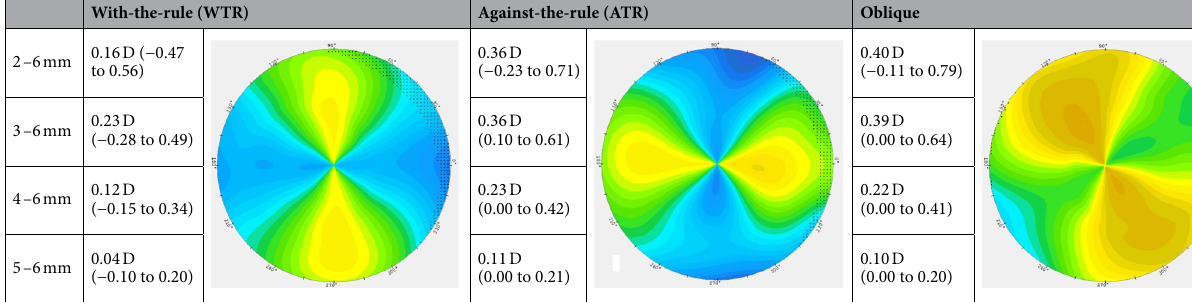
Table 3. Changes of the median absolute difference (IQR) in astigmatism found in three types of